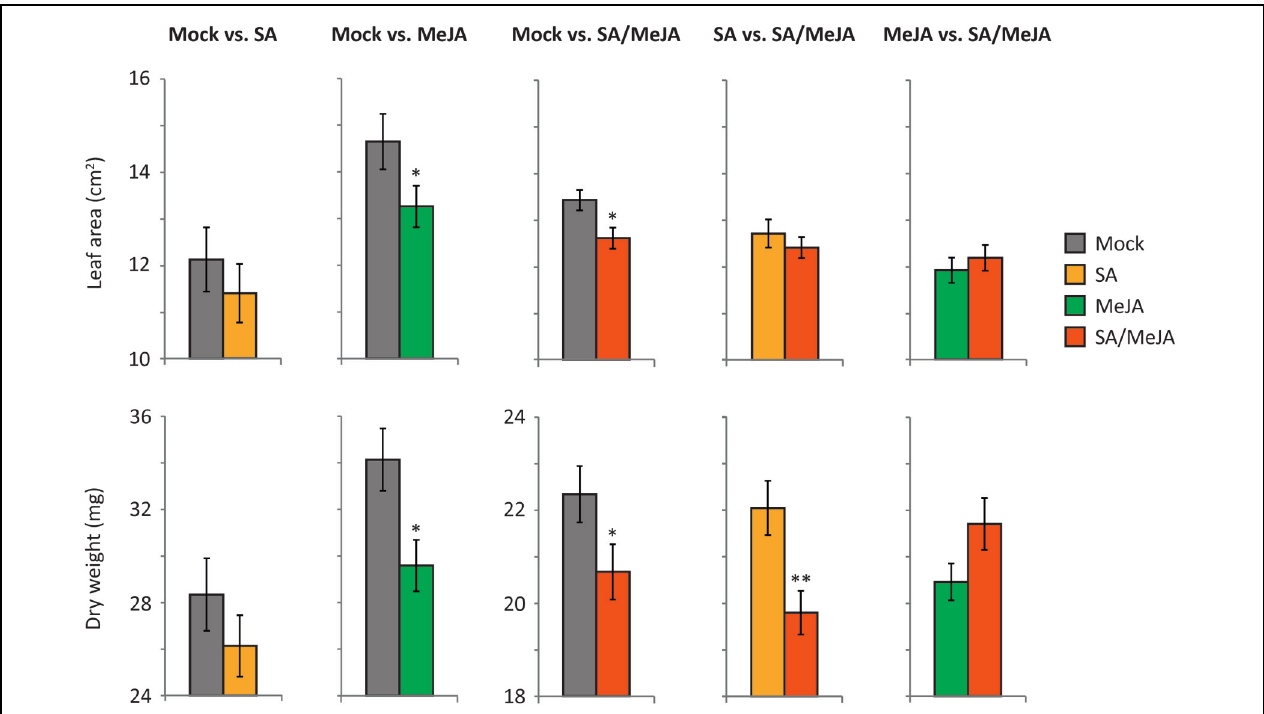
FIGURE 6 | Growth parameters in competition-grown plants. Leaf area (cm 2 ) and dry weight (mg) of the rosettes of competition-grown plants 3 weeks after treatment with a mock, SA, MeJA, or SA/MeJA solution. Mock vs. SA and Mock vs. MeJA competition experiments were performed in one experimental round, and Mock vs. SA/MeJA, SA vs.